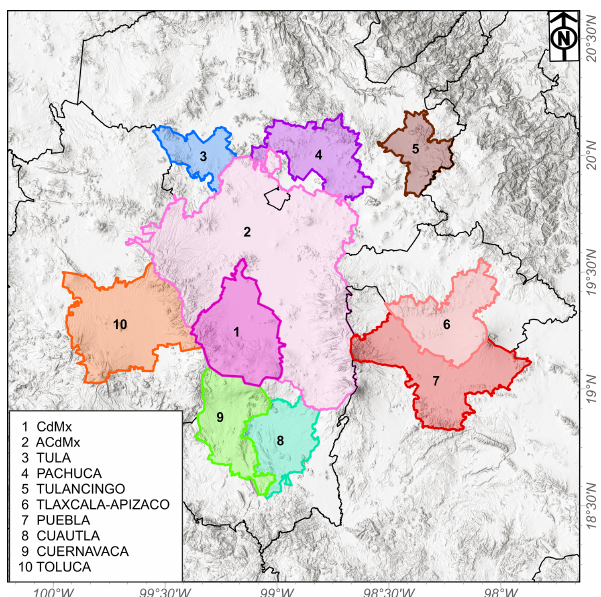
Figure 1. Urban districts surrounding Mexico City. For each of the color-coded domains a separate WRF-Chem tracer run was per- formed based on the emissions within the polygons. The eleva- tion map in the background is under copyright © Esri, Airbus DS, USGS, NGA, NASA, CGIAR, N Robinson, NCEAS, NLS, OS, NMA, Geodatastyrelsen, Rijkswaterstaat, GSA, Geoland, FEMA, Intermap, and the GIS user